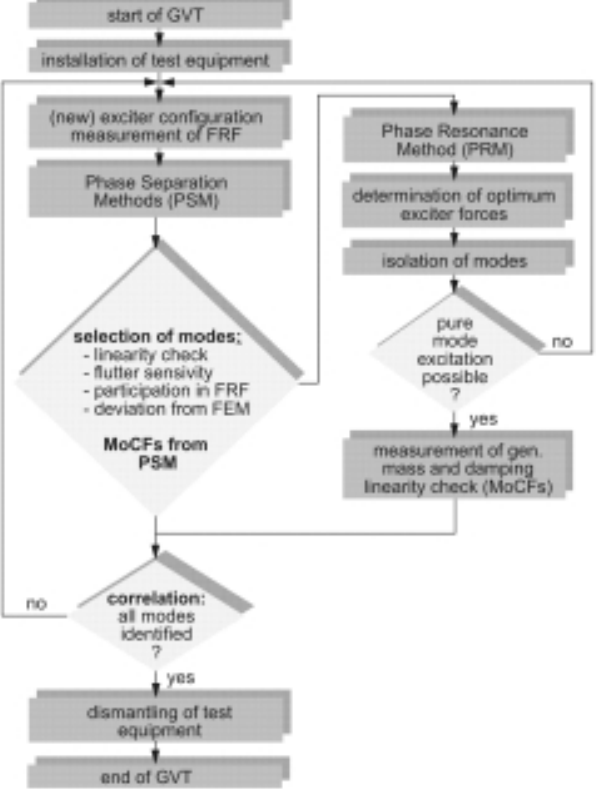
Fig. 1. Modal identification concept for large aerospace